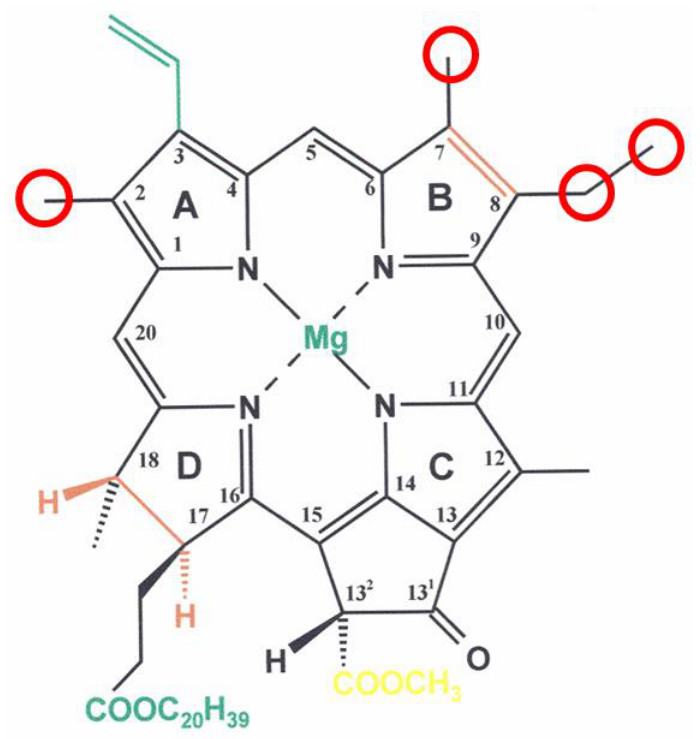
Figure 1. Structure of Chl a. Circles and colored bonds indicates modified sites in other Chls and BChls. Chl b and Chl f have a 7- and 1-CHO group, respectively . BChls c, d and e are characterized by lacking the 13 2 -COOCH 3 , by a CHOH-CH 3 –group at C2 (both stereoisomers), they differ by methylations at C20 and at the C8 and C12 substituents. In BChls a, b and g, the 7,8-double bond replaces the single bond, they differ in the substituents at C3,7 and/or 8. The c-type Chls are characterized by a 17,18-double bond, they differ by further modifications. Additional modifications in certain (B)Chls are replacements of the phytol esterifying the 17–propionic acid by other alcohols, mainly derived from farnesol or geranylgeraniol, exchange of the central Mg 2+ by Zn 2+ or inversion of the stereochemistry at C13 2 . For further readings, see Ref. 24.